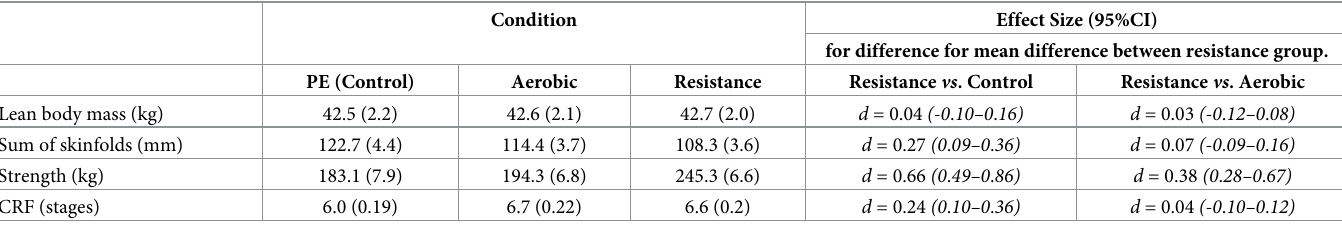
Table 3. Effectiveness of resistance and aerobic training compared to PE (controls). Estimated marginal means adjusted for baseline values (standard